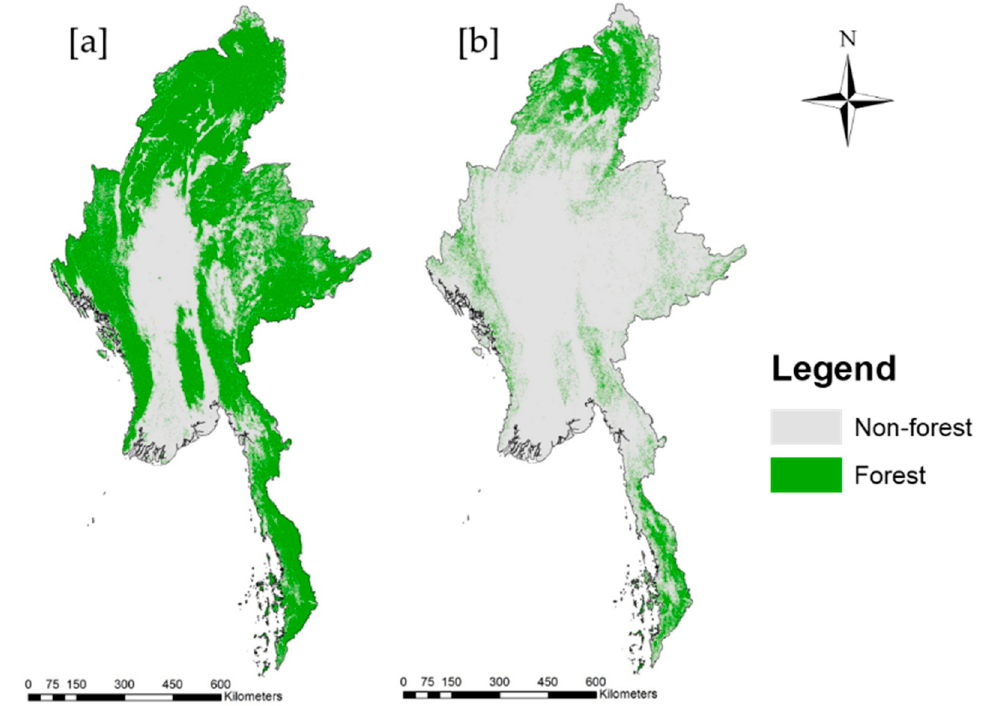
Figure 6. Forest cover maps for 2016 developed from the Global Forest Cover Database (GFCD) using original tree cover percent in 2000 [10] and ( a ) 40% tree cover threshold, or ( b ) 90% tree cover threshold.